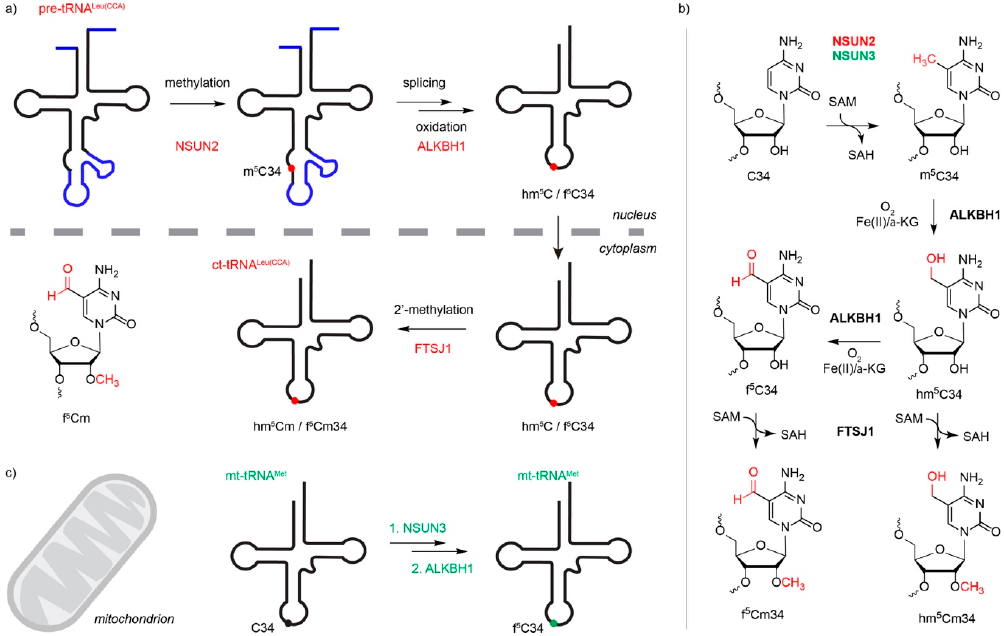
Figure 4. Hypermodification of m 5 C34 in anticodon of cytoplasmic and mitochondrial tRNAs. ( a ) During the maturation of the cytoplasmic tRNA Leu(CAA) , an m 5 C34 modification is installed